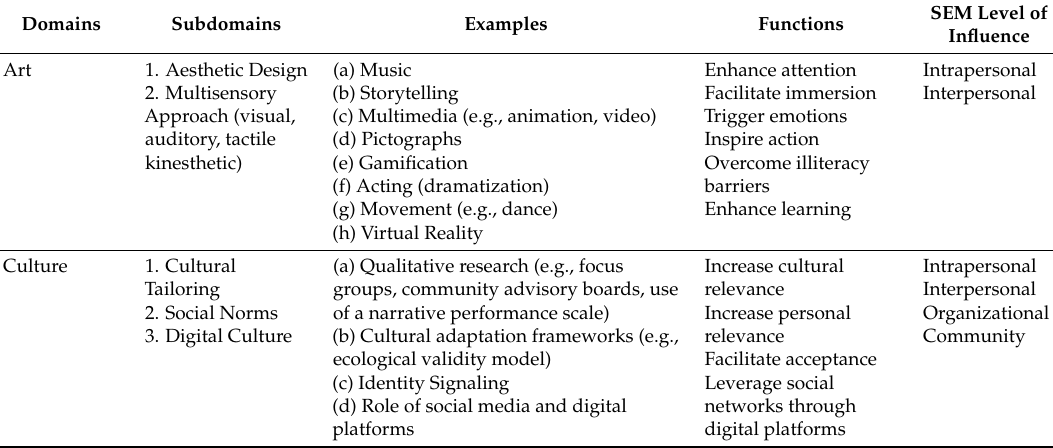
Table 1. The Multisensory Multilevel Health Education Model—Domains, Subdomains, Examples, Functions, Socio-Ecological Model (SEM) Level of